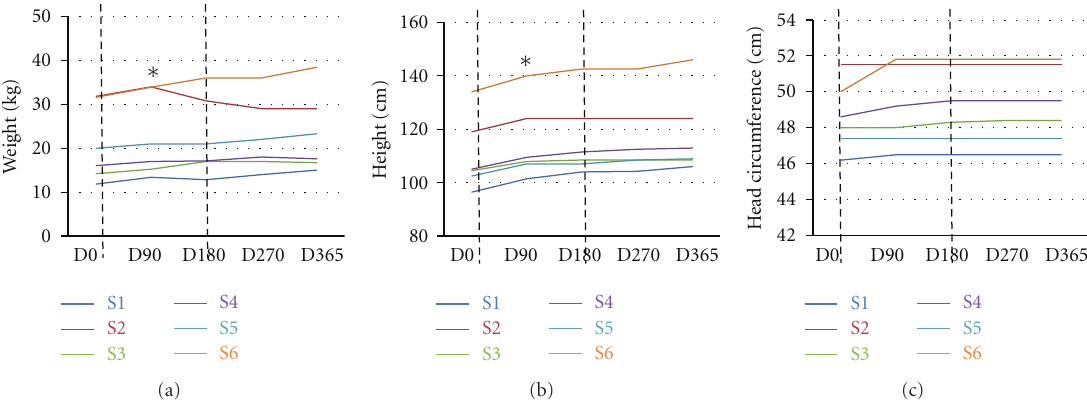
Figure 2: Growth parameters progression during IGF1 treatment. The figure reports the increase/decrease in weights (a), height (b), and head circumference (c) in each patient for one year, starting from Day0, D0 (first day of treatment, before IGF administration). The measurements were taken at D90 (90 days after the first IGF1 administration), D180 (180 days after the first IGF administration, last day of IGF1 treatment), D270 (270 days after the first IGF administration), D365 (365 days after the first IGF administration). The dotted lines represent the start (D0) and the end (D180) of the treatment. Each patient is color-coded: S1: blue, S2: red, S3: green, S4: purple, S5: cyan, and S6: orange. (a) Changes in body weight are expressed in kgs. There is an increase in body weight for each patient, with the exception of S2, who after D90 shows a decrease in body weight. The increase between D0 and D90 is significant (Wilcoxon test). (b) Changes in height are expressed in cms. The patients show a significant increase in height between D0 and D90 (Wilcoxon test). (c) Changes in head circumference are expressed in cms. The patients show an initial—but not significant—increase in head circumference between D0 and D90.